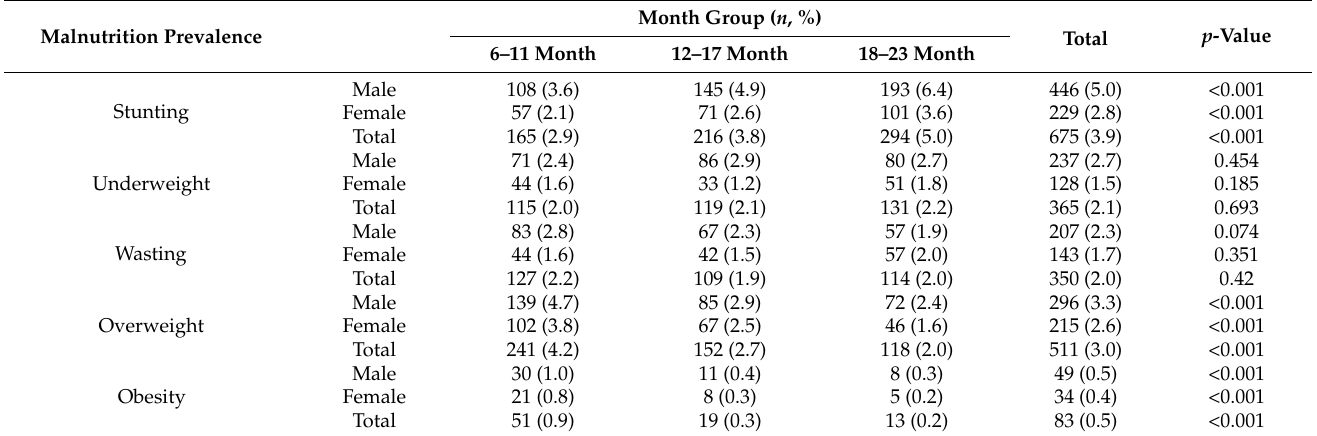
Table 3. Prevalence of malnutrition among 6–23-month-old infants.